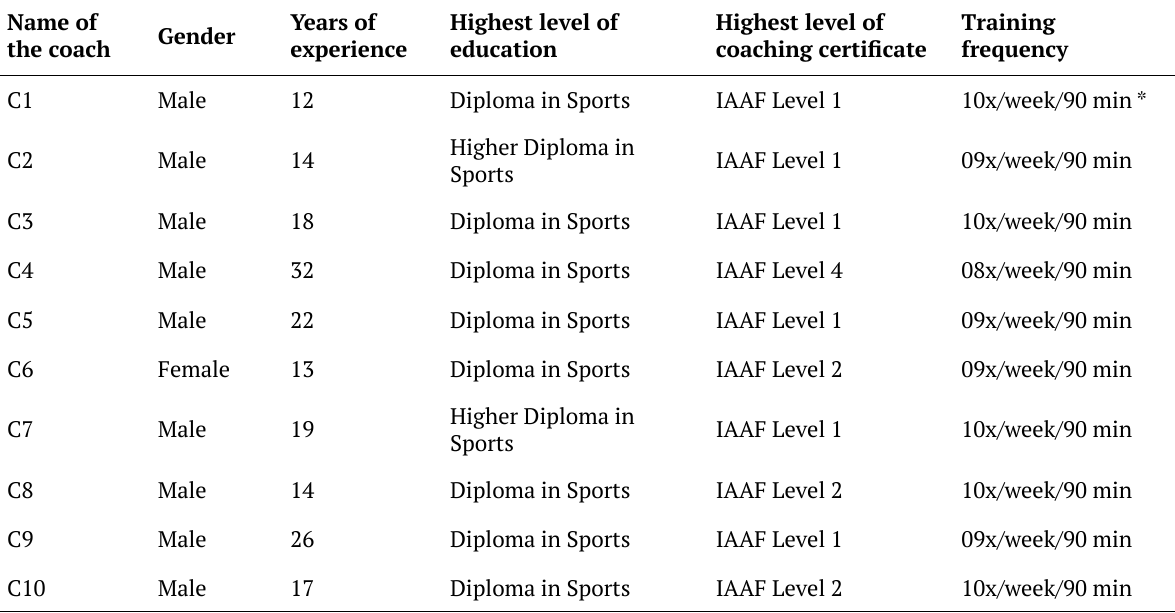
Table 1. Demographic profile of the short-sprint coaches interviewed Name